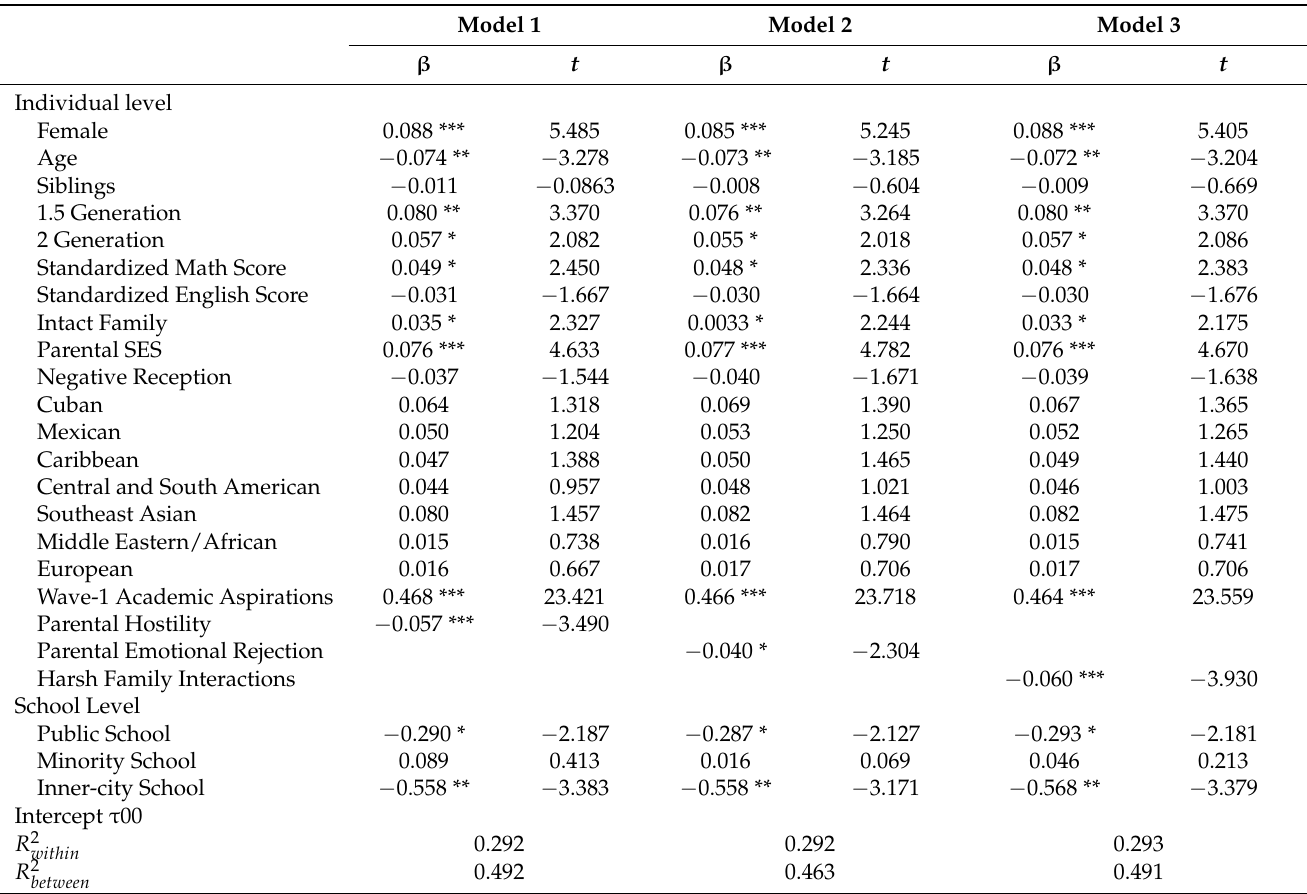
Table 3. Generalized linear mixed modeling predicting the effects of parental hostility, emotional rejection, and harsh family interactions with parents in early adolescence of immigrant youths on academic aspirations of immigrant youths in late